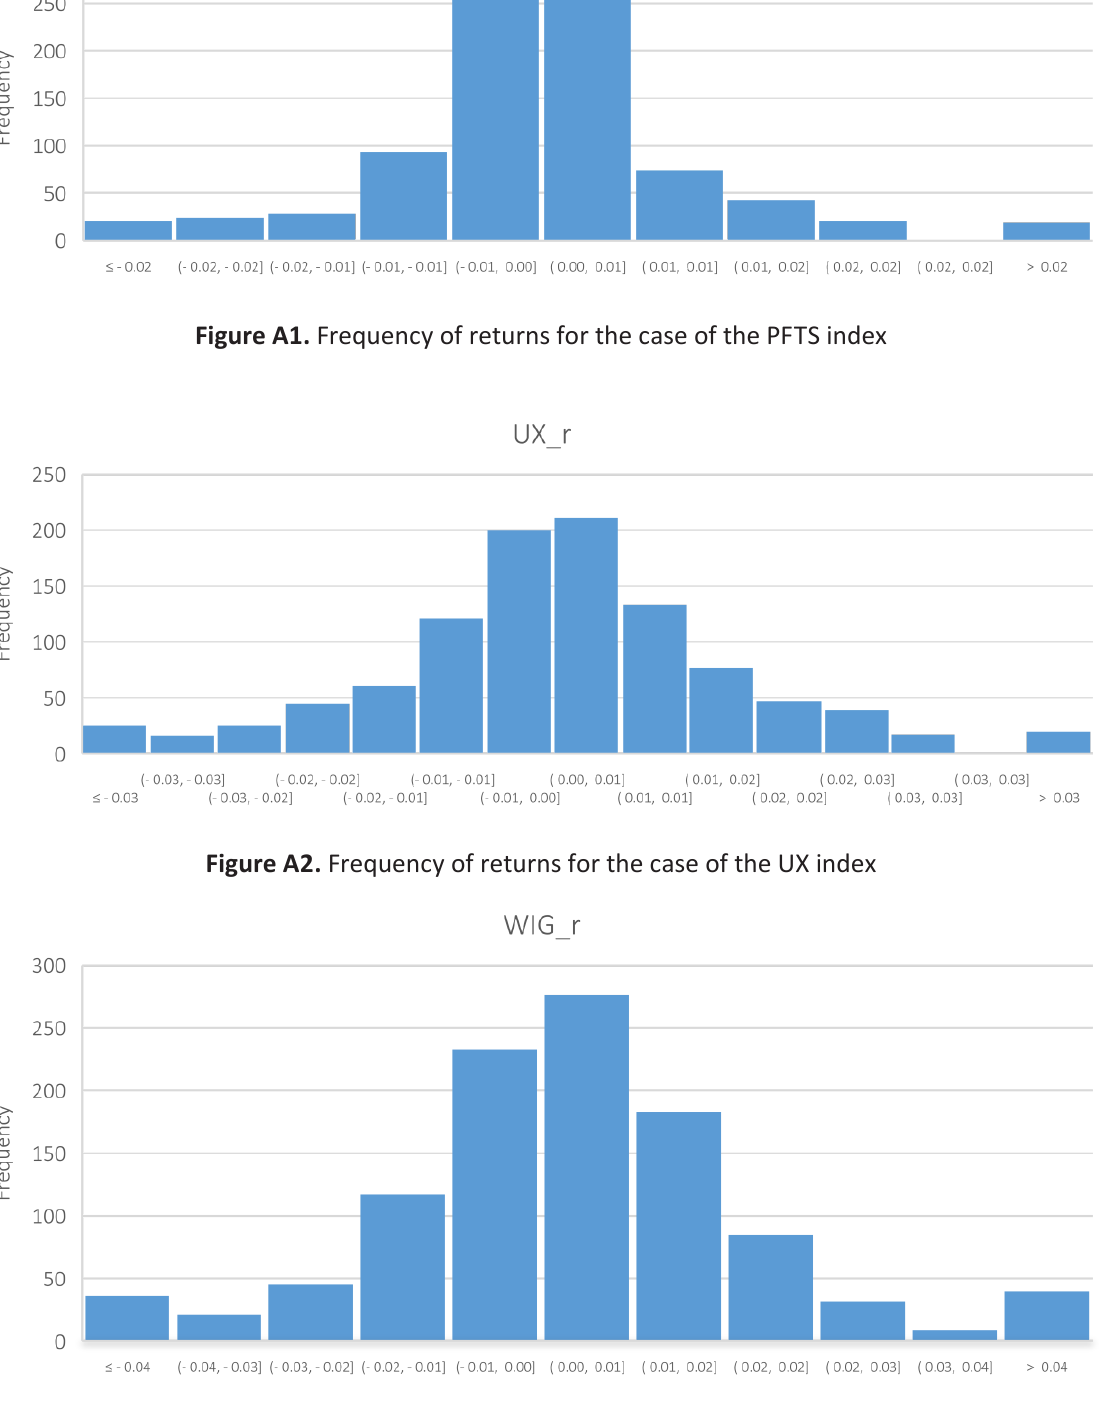
Figure A3. Frequency of returns for the case of the WIG Ukraine index